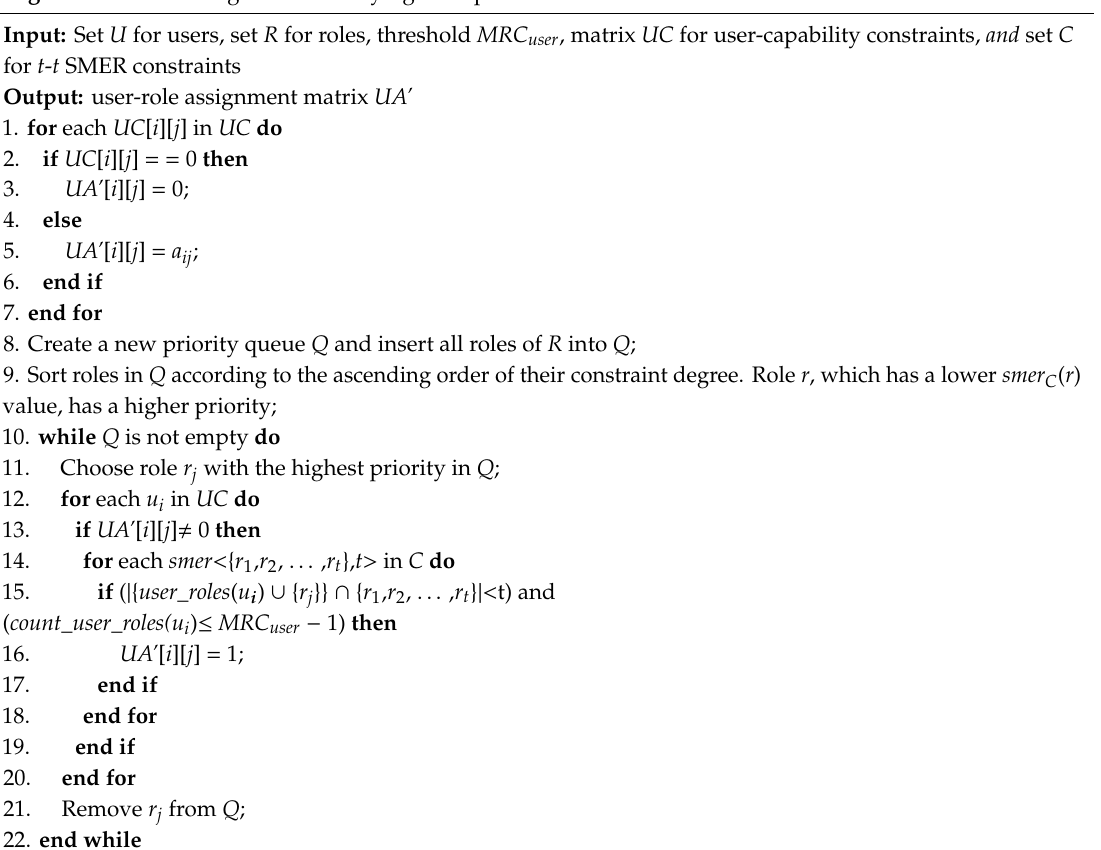
Algorithm 7. Role assignments satisfying multiple